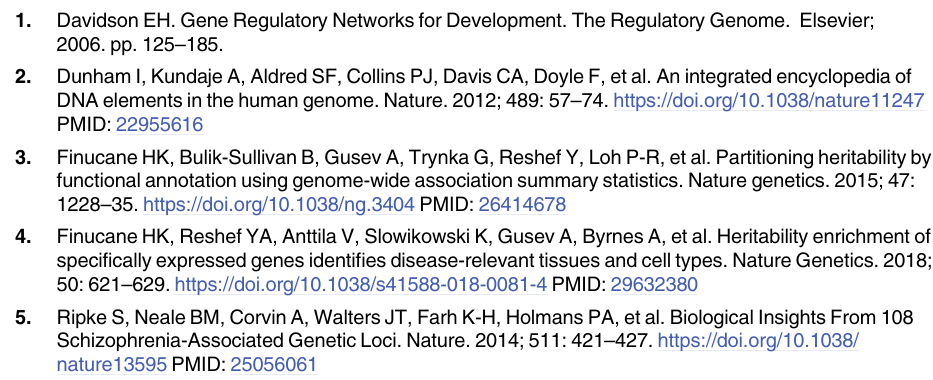
S4 Table. Untransformed LDSC result